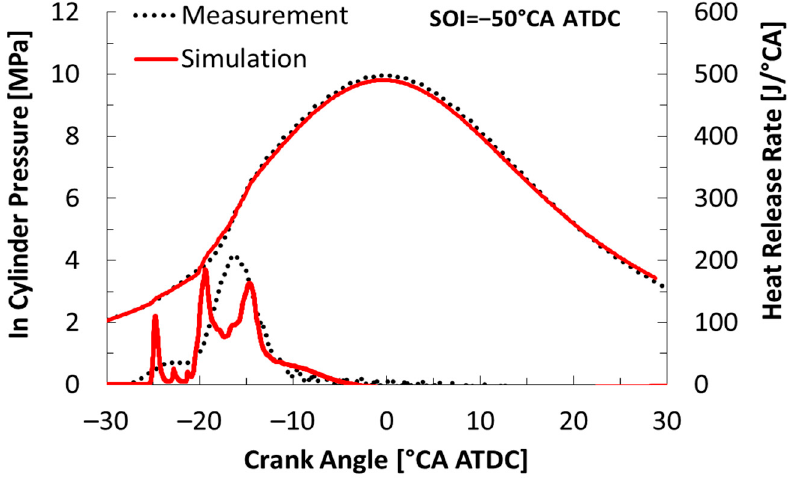
Figure 5. Comparison of experimental and CFD simulation results of in-cylinder pressure and AHRR histories for SOI of − 50 °CA ATDC.